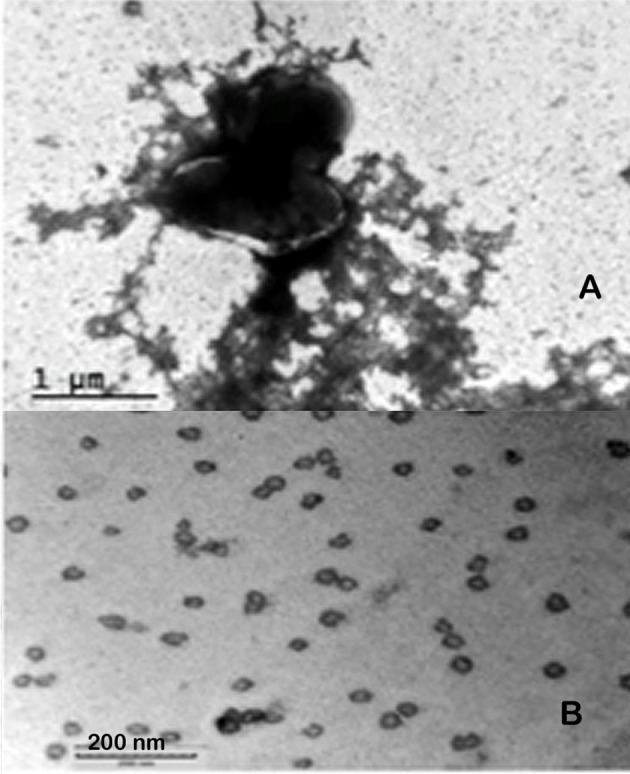
TEM of F. tularensis WbtIG191V enhanced for CLC expression, and CLC extracted with urea. (A) Whole bacteria surrounded by CLC; (B) urea-extracted CLC. Whole cells were fixed with glutaraldehyde before staining and all samples were negatively stained with 0.5% uranyl acetate.